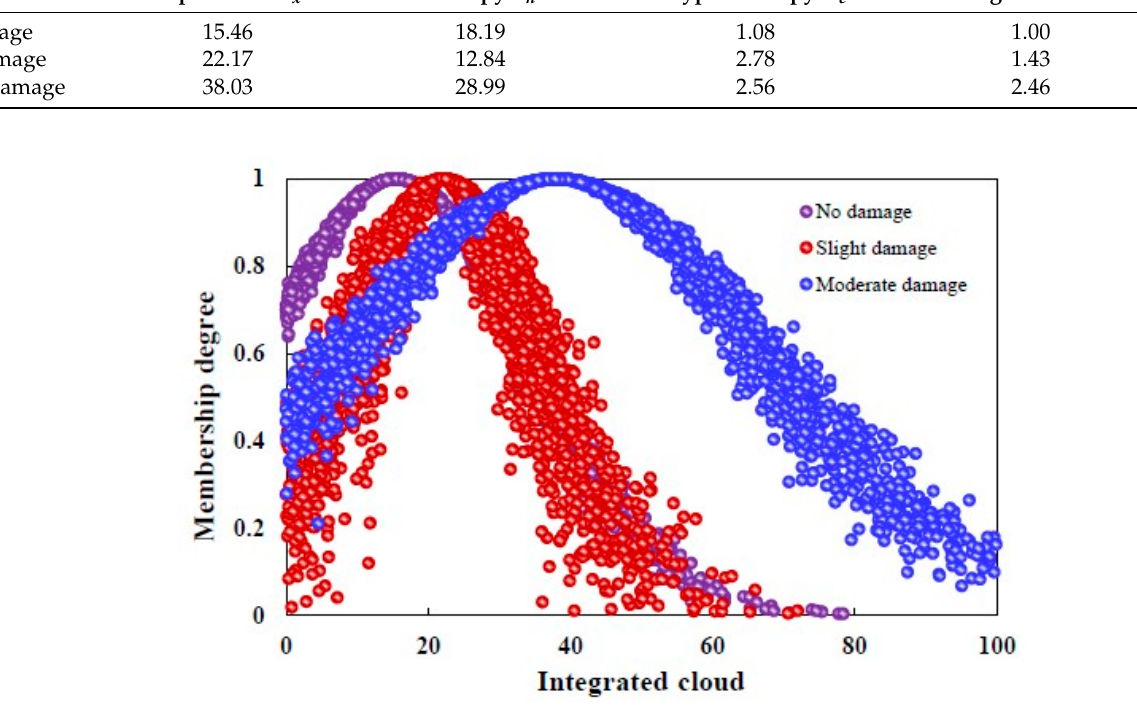
Figure 10. Distribution of membership degrees of different damage levels based on the integrated cloud model. cloud